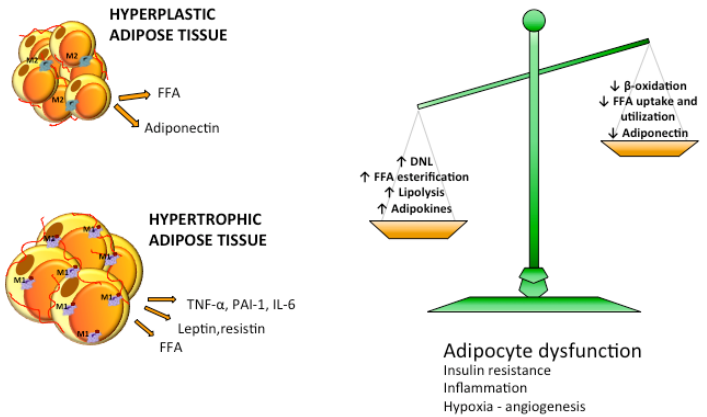
Figure 4. Imbalance in lipid metabolism causes increased efflux of FFA to adipose tissue. Reduced free fatty acids (FFA) utilization and β -oxidation and increased lipogenic and lipolytic pathways lead to overflow of FFA in the circulation. Adipose tissue activates adipogenesis and increases the number of adipocytes becoming hyperplastic or enlarges adipocyte size becoming hypertrophic. Hyperplastic adipose tissue is normally metabolically healthy while hypertrophic adipose tissue is characterized by dysfunctional adipocytes, insulin resistance, hypoxia and inflammation. During adipose tissue expansion adipocytes become either hyperplastic, when their number increases through adipogenesis, or hypertrophic, when their size increases via lipogenesis [77] (Figure